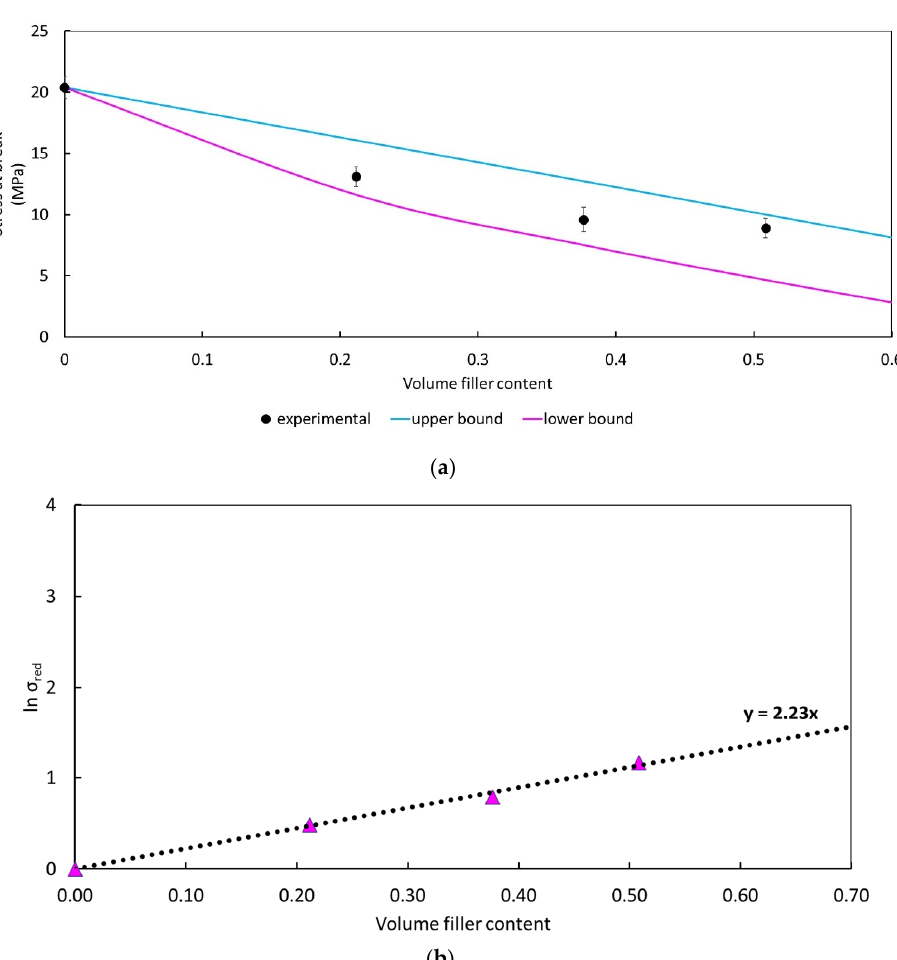
Figure 5. ( a ) Comparison between the experimental composites strength and the values predicted according to the analytical models illustrated in Section 2.1. Volumetric fractions are derived from the weight fractions calculated by using the density of each component taken from data sheets; ( b ) Pukánszky’s plot for PLA/PBSA plasticized composites . The poor adhesion is also confirmed by the B value obtained from the Pukánszky’s plot (Figure 5b) where a B value equals to 2.23 was obtained. Being the B value obtained greater than 2.04, the Equation (5) was used for the IFSS estimation and the value, reported in Table 3, was also compared to other similar composites systems containing natural fi- bers. The IFSS value obtained can be retained acceptable because it is inferior to its maxi- mum theoretical threshold value achievable calculated by the Von Mises relationship [71] ( τ = σ m / √ 3 ) equal to 11.78 MPa; furthermore the IFSS value obtained is comparable to sim- ilar bio composites described in literature. Table 3. IFSS obtained for the composites system analyzed compared with literature data of similar systems . Reference